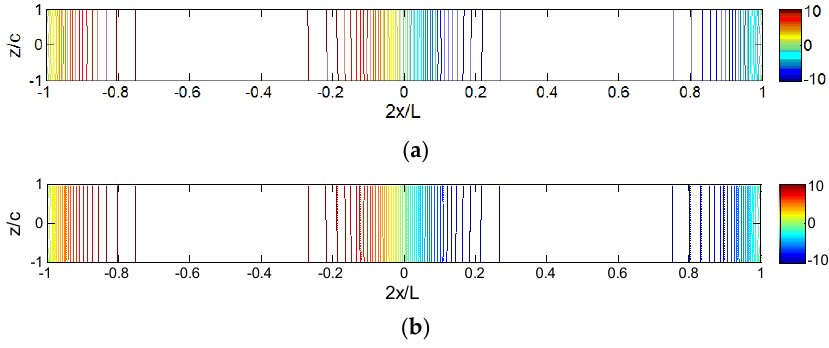
Figure 7. Comparisons of iso-displacement ( τ xz / q ) diagram for sandwich panels under locally distributed loads ( L p = 0.1 L ): ( a ) HDQM; and ( b ) ABAQUS.